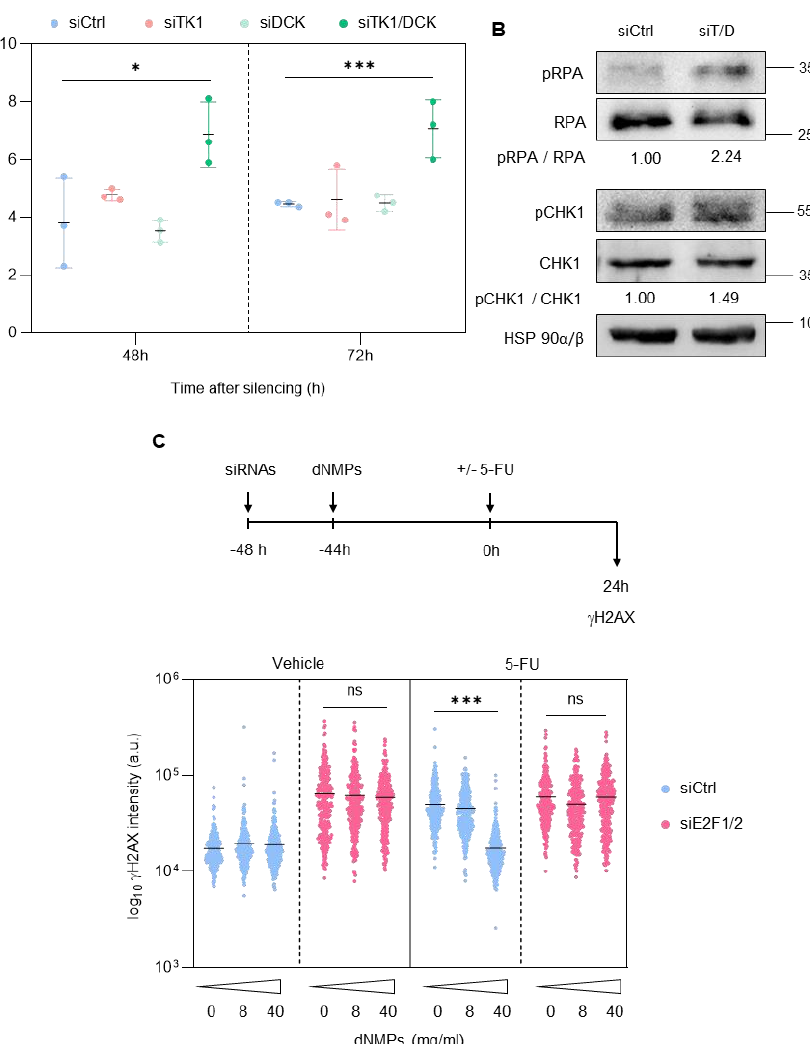
Figure 5. Combined TK1 and DCK activity contributes to maintain genomic stability but fails to rescue DNA damage of E2F1/E2F2 knockdown cells. ( A ) Percentage of γ H2AX-positive cells at the indicated time points after transfection with siCtrl, siTK1, siDCK or siTK1/DCK. Data shows the average ± SD from 3 independent experiments. ( B ) Representative Western blot analysis of several replication stress response markers in extracts prepared from PC3 cells 72 h after transfection with siCtrl or siTK1/DCK (siT/D). HSP90 was used as loading control. Densitometric values were used to calculate phospho-to-total protein ratios, expressed as fold-over siCtrl sample. ( C ) Schematic representation of the experimental design. PC3 cells were co-transfected with siE2F1 and siE2F2 with set #1 oligos. Then, 4 h later, cells were treated with 0, 8, 40 mg/mL of dNMP, and 20 h later, treated with 5-FU (5 µ M). Intensity of γ H2AX signal in cells in S phase 24 h after the indicated treatments is represented. Data are expressed as Log10 intensity. Horizontal bars mark mean intensity. Data of 300 cells from one representative experiment of three independent experiments are shown. Statistical analysis was performed using ANOVA and Fisher’s test. *** p < 0.0001, * p < 0.05, ns =